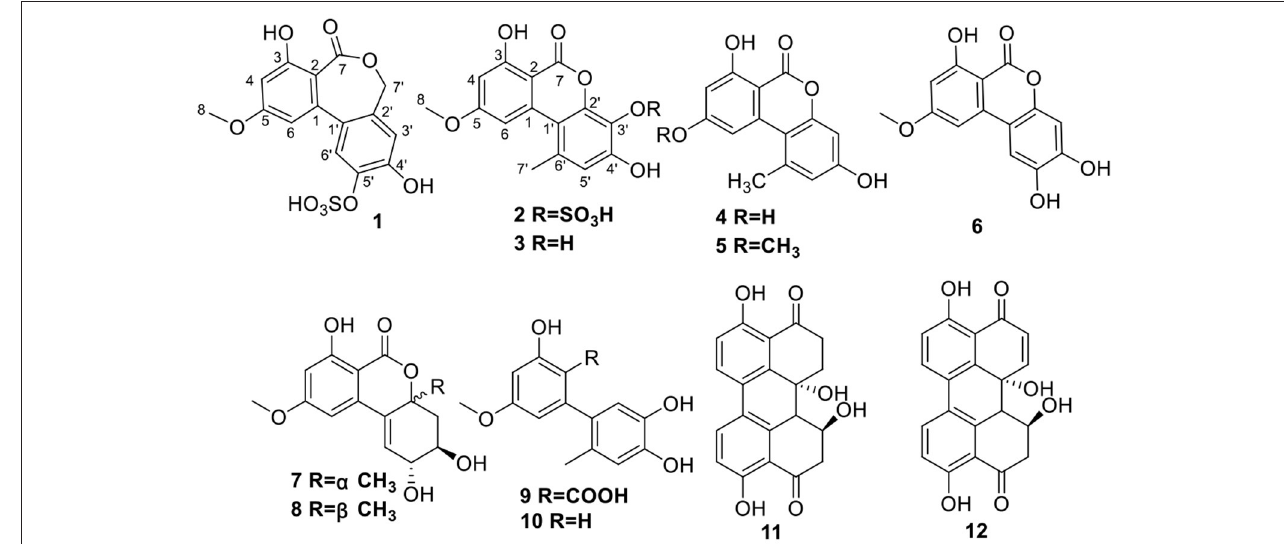
FIGURE 1 | Structures of compounds 1 – 12